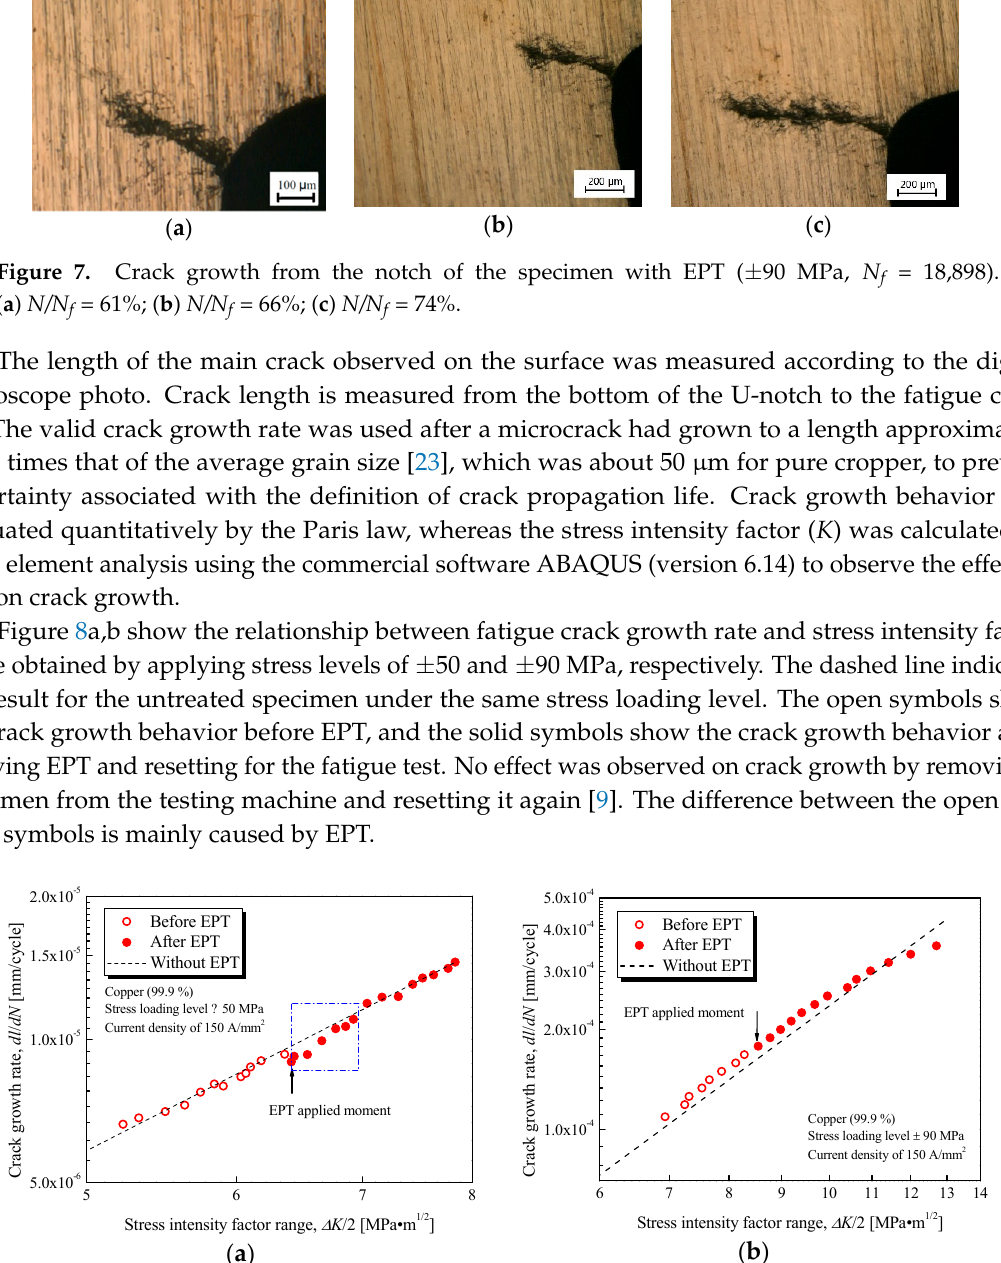
Figure 8. Fatigue crack growth rate as a function of the stress intensity factor range for specimens with and without EPT: ( a ) ±50 MPa loading level; ( b ) ±90 MPa loading level.